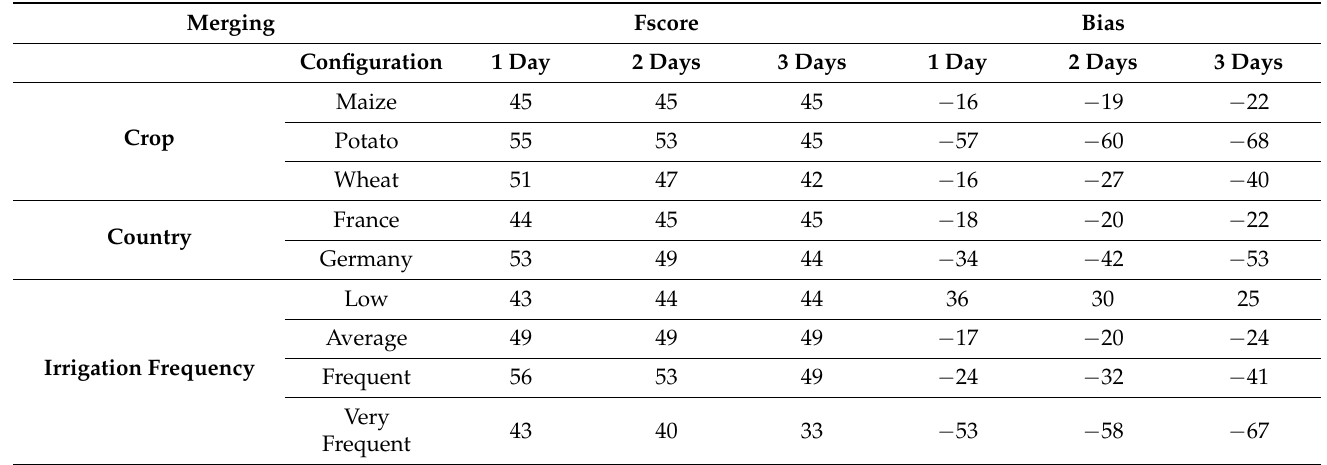
Table 3. Scores (F-score, bias) of the merging of irrigations runs according to 3 merging windows (one day, two days, three days) and according to crops, country, and irrigation